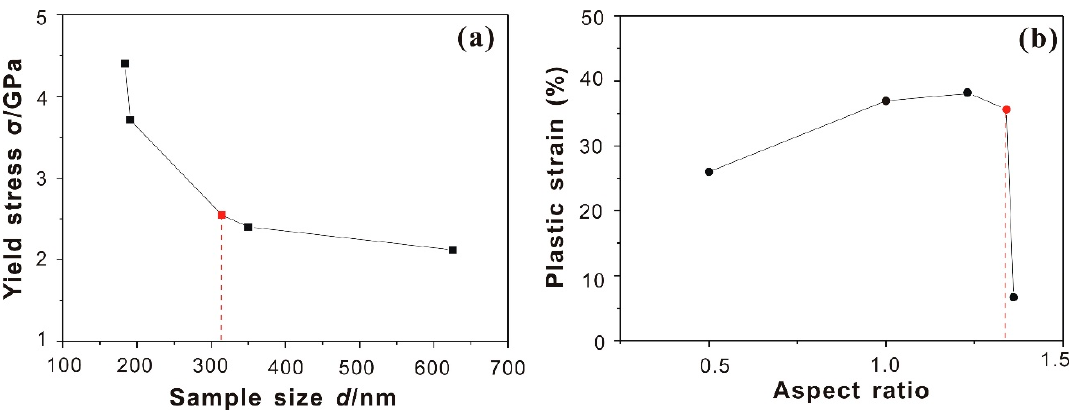
Figure 4. ( a ) Yield stress as a function of cube size, clearly revealing a size effect for dislocation-free Ni 3 Al nanocubes. ( b ) Plastic strain as a function of aspect ratio exploring the effect of aspect ratio